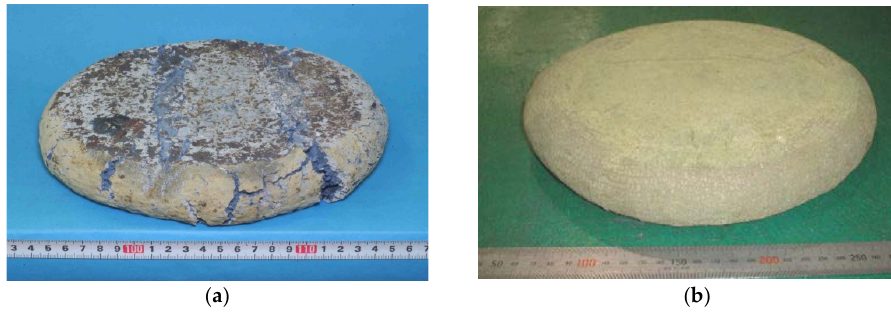
Figure 1. Appearance after hot-forging: ( a ) ordinary TiAl alloy and ( b ) Ti-42Al-5Mn.